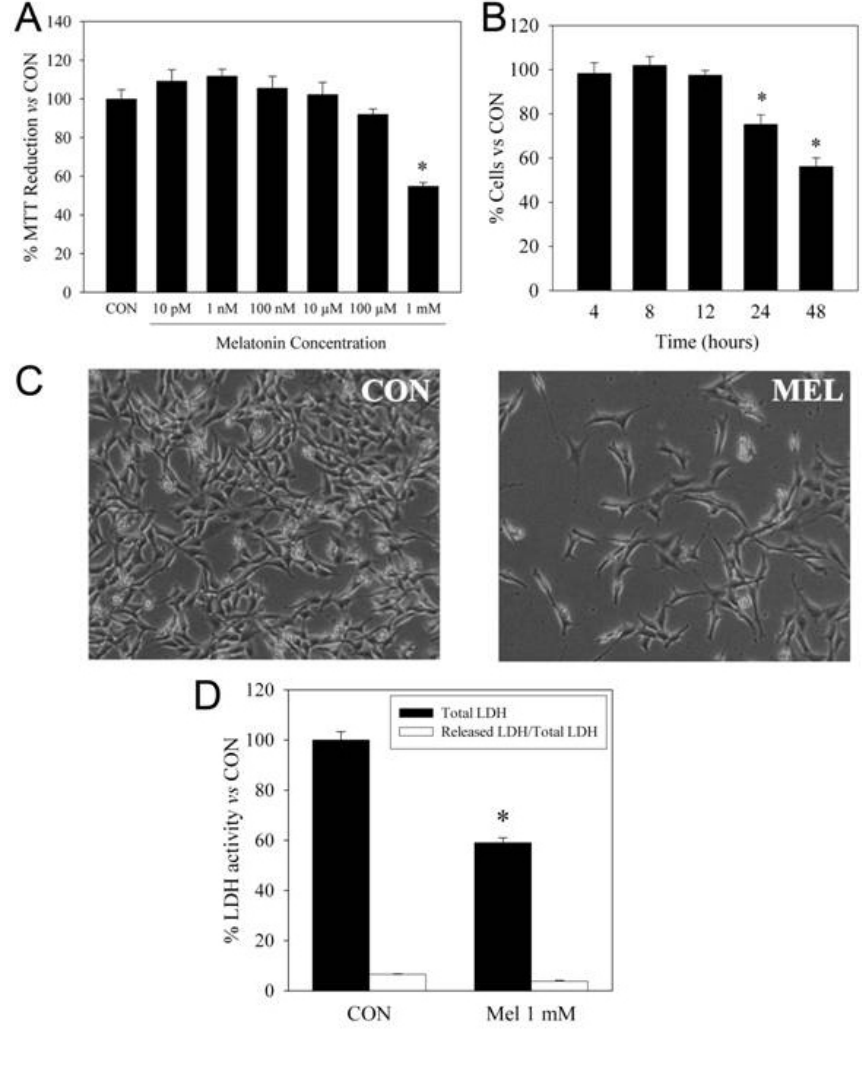
Figure 1. Melatonin effects on the hippocampal HT22 cell line. ( A ) Cells were